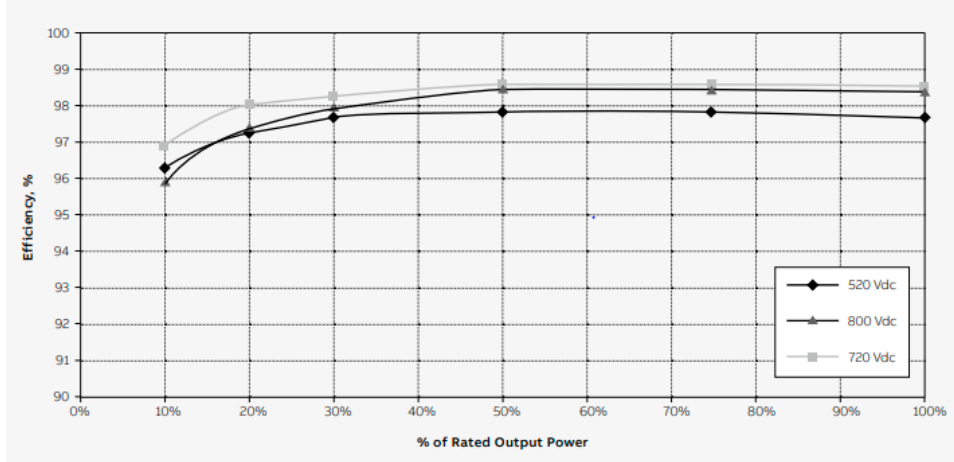
Figure 4. Change in efficiency with respect to operating power and input DC voltage [43].